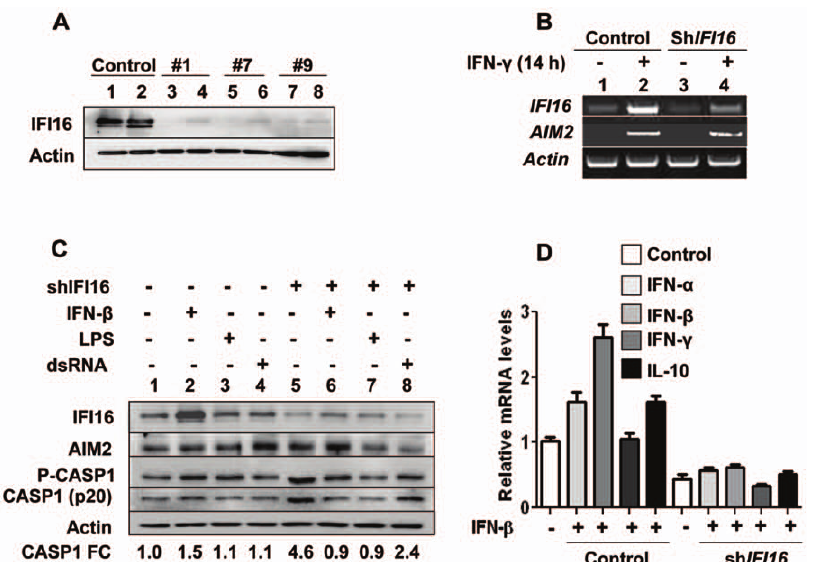
Figure 5. Knockdown of IFI16 expression increases the constitutive levels of the activated casapase-1. ( A ) Puromycin-resistant THP-1 cells either infected with control lentivirus (lanes 1 an2) or the virus expressing the shIFI16 RNA (lanes 3–8; cell populations from three different wells) were either left untreated (lanes 1, 3, 5, 7) or treated with IFN- a for 14 h. After treatment, total cell extracts containing increased amounts of proteins ( , 100 m g/lane) were analyzed for the constitutive and induced levels of IFI16 and actin proteins. A long exposure was taken to detect the signal in all lanes. ( B ) Control THP-1 cells (lanes 1 and 2) or cell population from well # 9 (lanes 3 and 4) as shown in the panel (a) were either left untreated (lanes 1 and 3) or treated with IFN- a for 14 h (lanes 2 and 4). After the treatment, total RNA was analyzed for the steady-state levels of mRNA for the indicated genes. ( C ) Control THP-1 cells (lanes 1–4) or cells infected with virus expressing the shIFI16 mRNA (lanes 5–8; population # 9) were either left untreated (lanes 1 and 5) or treated with IFN- b (1,000 u/ml; lanes 2 and 6), LPS (100 ng/ml; lanes 3 and 7), or dsRNA (10 m g/ml; lanes 4 and 8) for 14 h. After the treatment, total cell lysates containing equal amounts of protein ( , 100 m g/lane) were analyzed by immunoblotting using specific antibodies to the indicated proteins. FC, indicates the fold change in the levels of the activated caspase-1 (the p20 band) with respect to the control (lane 1). ( D ) Control THP-1 cells or cells infected with virus expressing the shIFI16 mRNA (population # 9) were either left untreated (white columns) or treated with IFN- b (1,000 u/ml; columns 2–5 and 7–10) for 14 h. After the treatment, total RNA levels were analyzed for the indicated genes by the quantitative TaqMan real-time PCR. The ratio of the test gene to actin mRNA was calculated in units (one unit being the ratio of the test gene to actin mRNA). Results are mean values of triplicate experiments and error bars represent standard